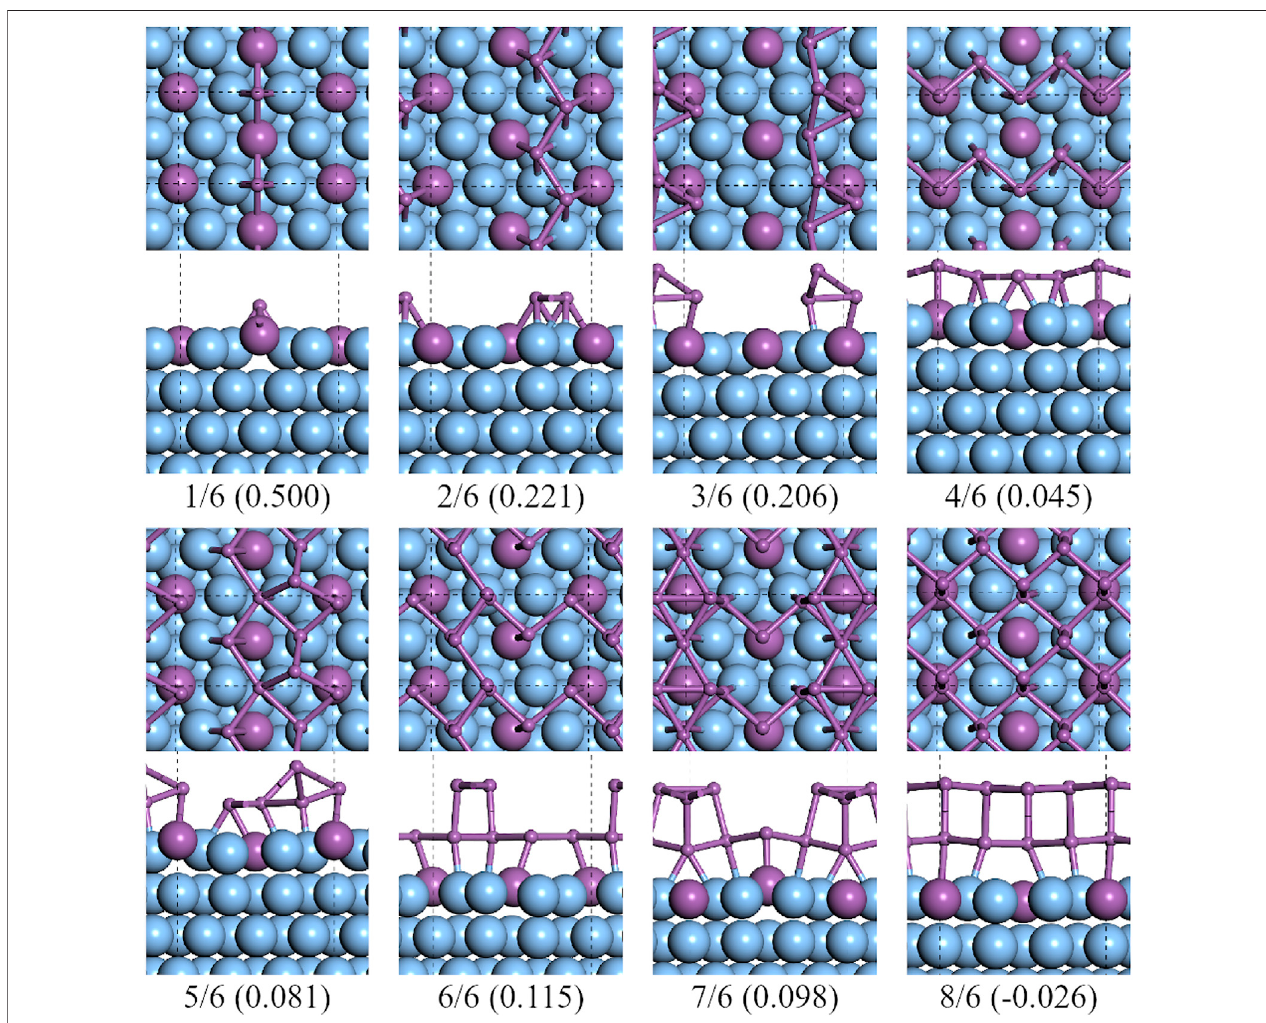
(cid:1)(cid:1) √ 3 Ag 2 Sb/Ag (111) substrate.